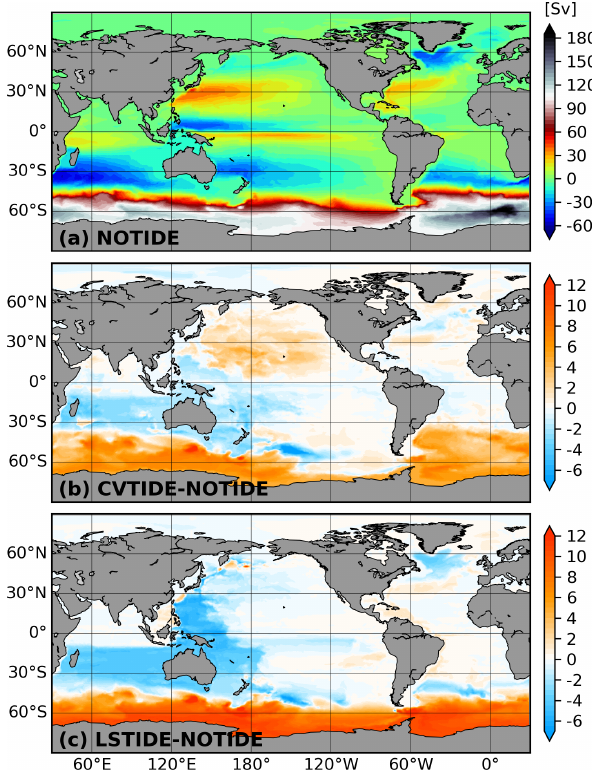
Figure 8. The barotropic streamfunction in the three sensitivity runs. Panel (a) shows the result in the control run, while panels (b) and (c) show the differences. Panel (c) also represents the tidal residual mean circulation. The calculation of barotropic streamfunc- tion in the unstructured mesh applies the algorithm introduced in Sidorenko et al.